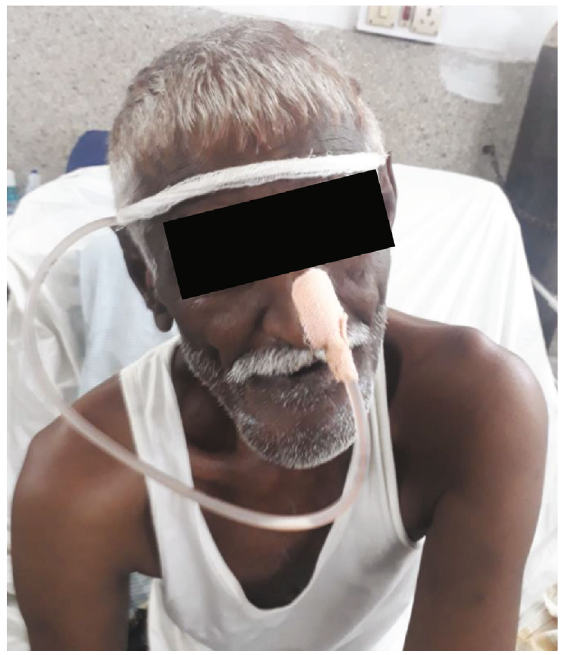
Figure 13: Plates in situ.